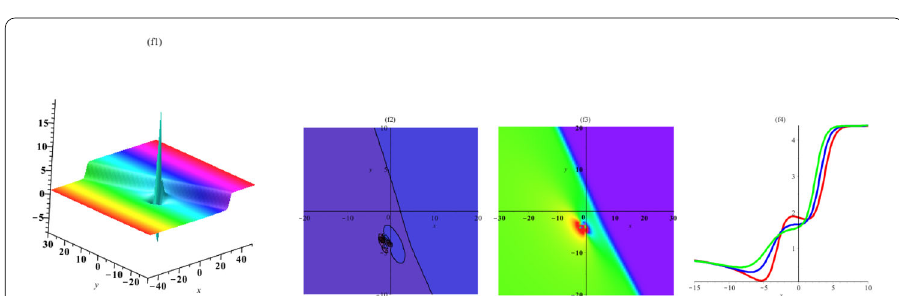
Figure 6 The plot of lump–kink (4.5) with fractional order α = 0.95